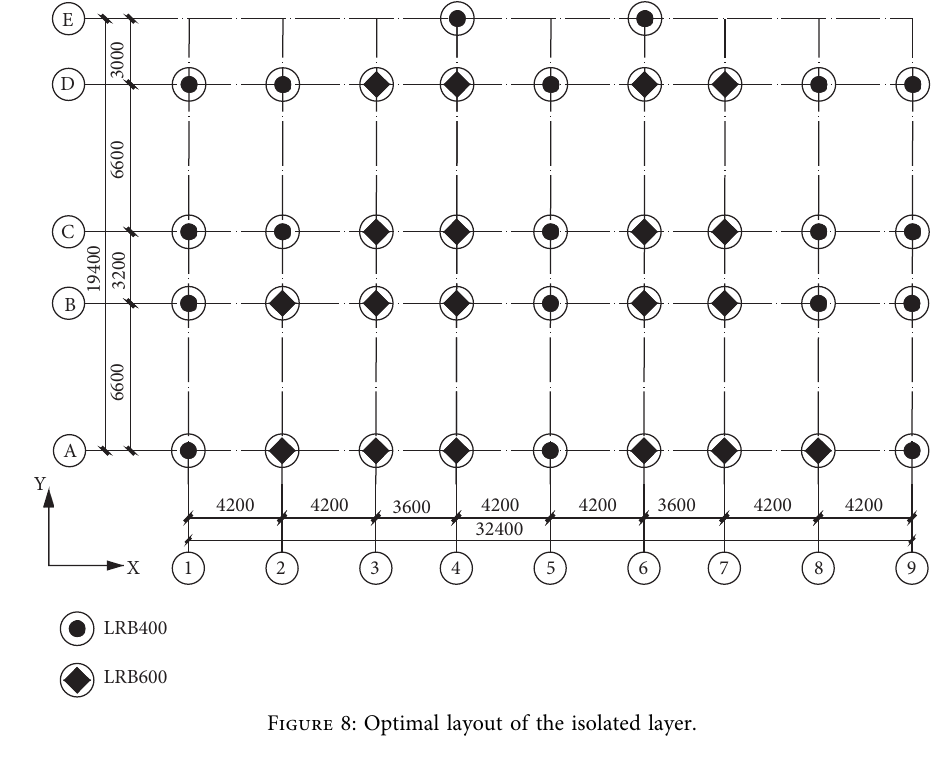
Figure 8: Optimal layout of the isolated